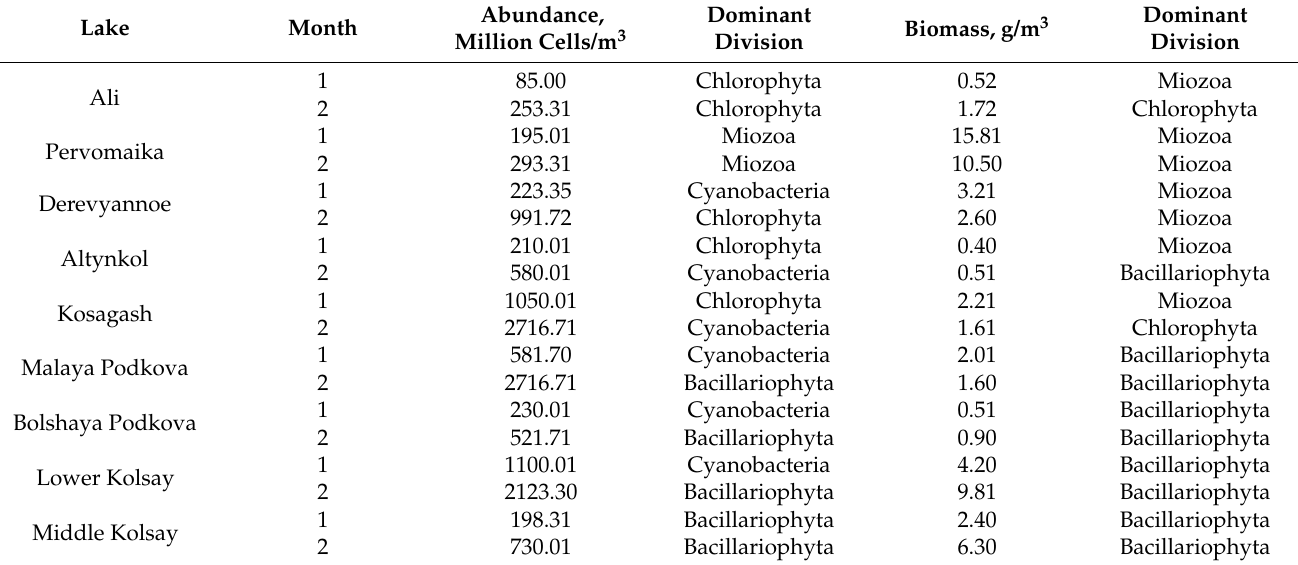
Table 4. The quantitative variables of phytoplankton in small lakes in South-East Kazakhstan, summer 2019. Lake